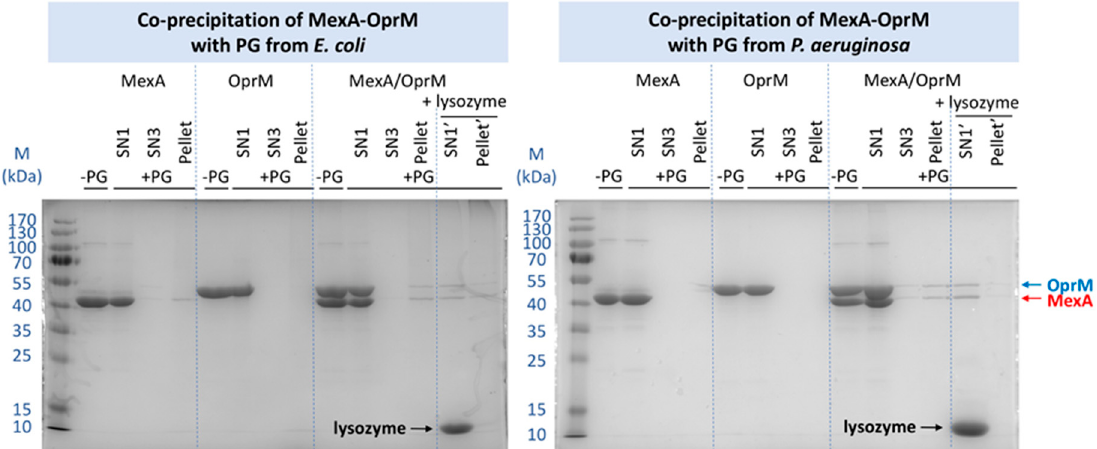
Figure 2. Pull-down experiments performed with the PG extracted from E. coli ( left ) and from P. aeruginosa ( right ), and with the MexA and OprM proteins in DDM detergent. M: marker of size in kDa; SNn: supernatant of the n washing and centrifugation step; Pellet: final pellet after the 3rd centrifugation; -PG: purified proteins without PG; +PG: pull-down with the PG; + lysozyme: extraction by lysozyme treatment of the remaining proteins from the final pull-down pellet after the three washing steps. SN1’: supernatant after lysozyme treatment after the first centrifugation; Pellet’: pellet after two washing and centrifugation steps.